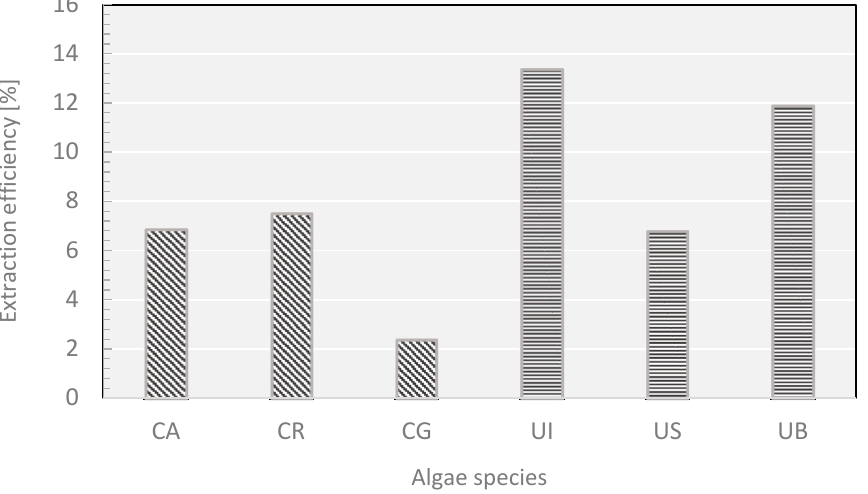
Figure 4. Percentage extraction efficiency of individual algae samples.